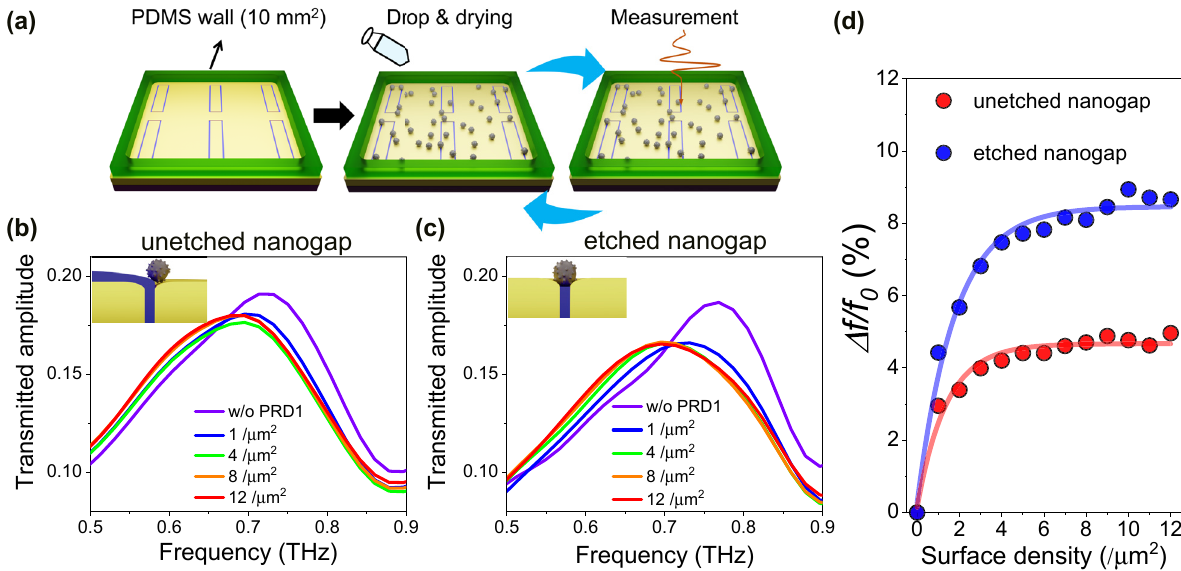
Figure 4: Spectral changes of the virus-coated nanogap-loop array. (a) Schematic diagrams of the drop-castingmethod with the PRD1 viruses. After dropping and drying the PRD1 virus solution inside the PDMS wall, the virus-coated nanogap samples are measured. This cycle (virus coating and THz measurement) is repeated to observe the terahertz spectral changes by increasing the virus density. Terahertz transmitted amplitude spectra for (b) unetched nanogaps and (c) etched nanogaps depending on the selected surface density of the PRD1 virus in the range between 1/ μ m 2 and 12/ μ m 2 . (Insets) Schematic diagrams of the PRD1 virus on the unetched and etched nanogaps. (d) Resonance frequency shift ( 𝛥 f/f function of the surface density (number of virus particles/ μ m 2